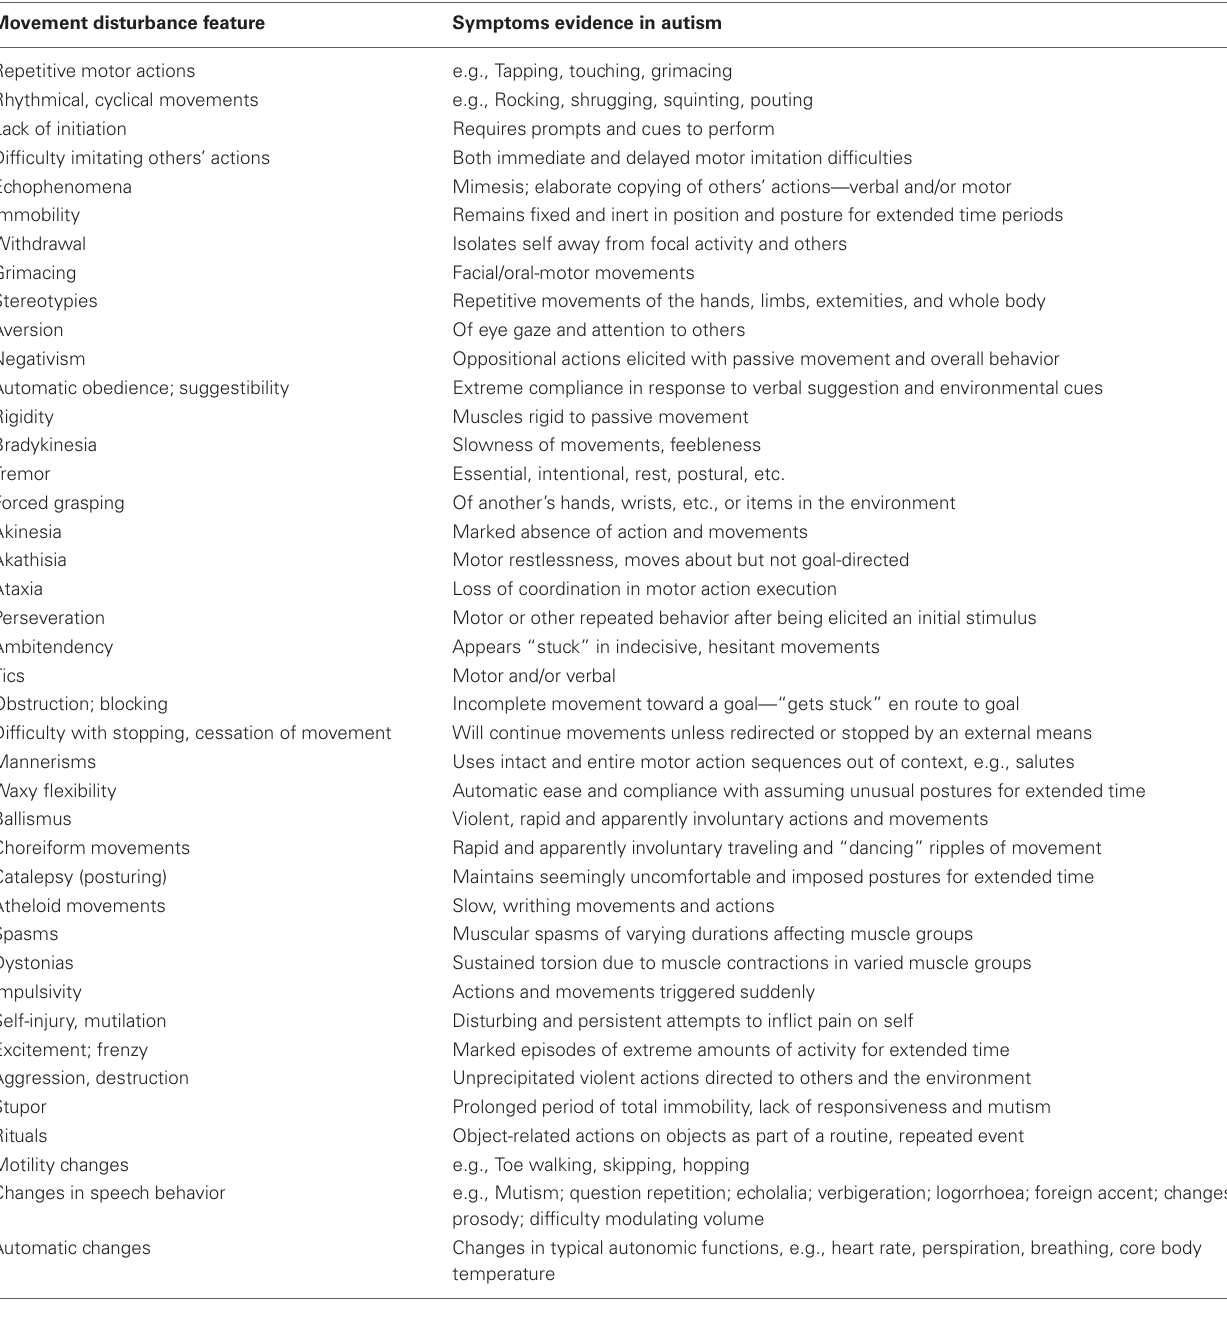
Table 1 | Characteristic features of substantial movement disturbances and evidence of possible overlap of symptoms in